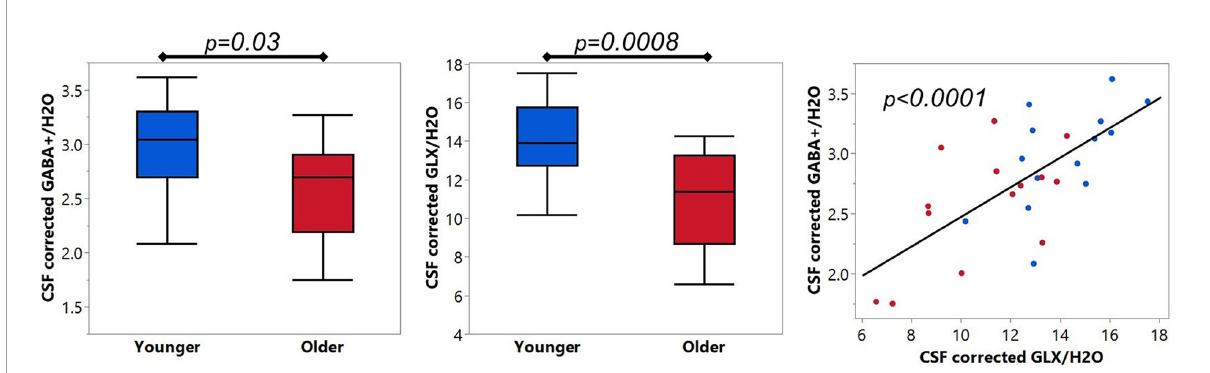
FIGURE5 (Left and Middle) panels show comparison of optimized GABA+ and Glx between younger ( N = 14) and older ( N = 14) cohorts. (Right) panel show s the expected linear relationship between GABA+ and Glx. Blue = younger, red =